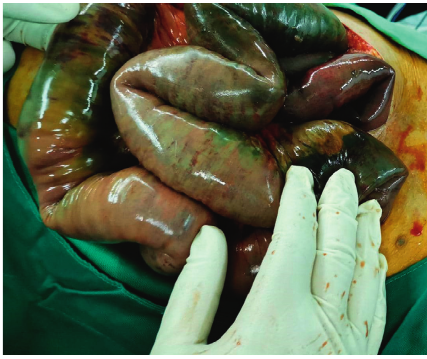
Figure 7: Photo of gangrenous small intestine of the